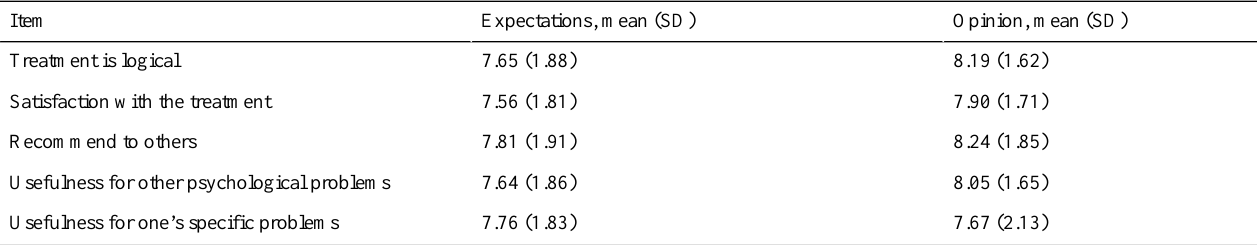
Table 5. Means and SDs for expectations and opinions of treatment